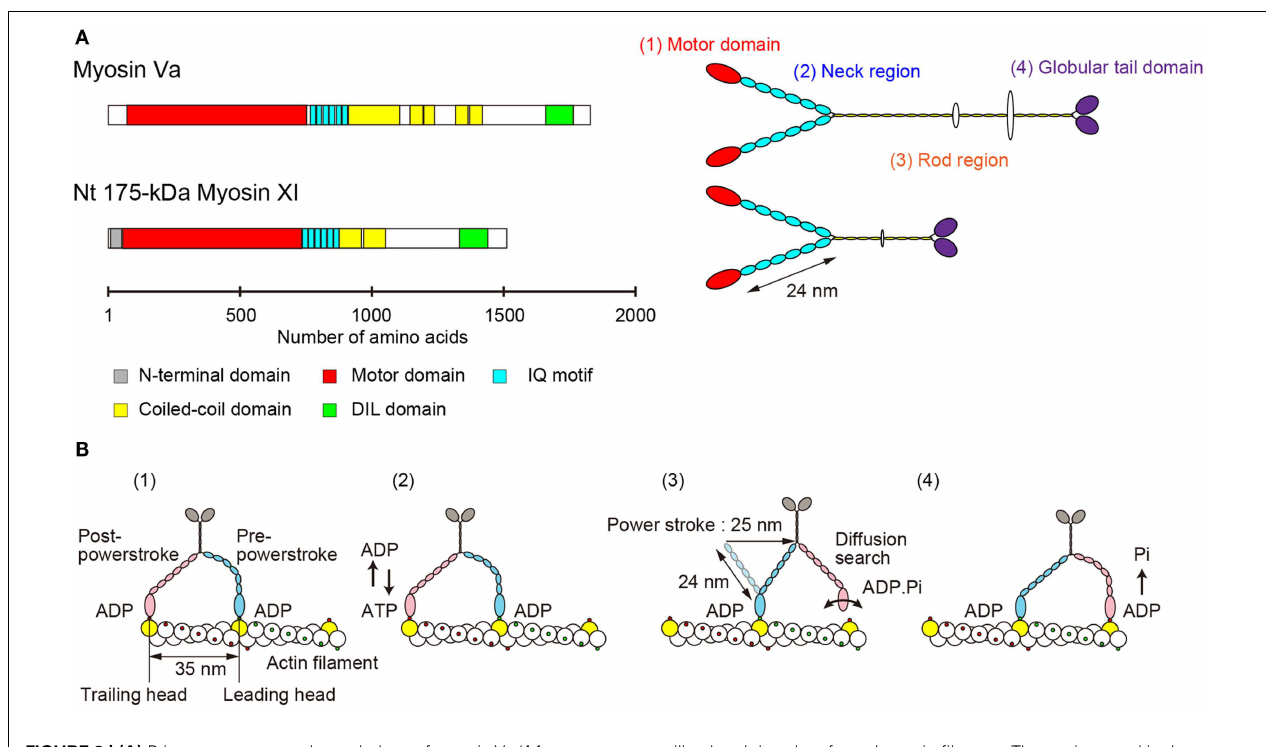
FIGURE 2 | (A) Primary structure and morphology of myosinVa ( Mus musculus ) and Nt 175-kDa myosin XI ( Nicotiana tabacum ). (B) A general model for stepwise processive movement. (1) Both heads with ADP are strongly bound to actin subunits 35nm apart (yellow).The trailing head (red) is in a post-powerstroke state, and the leading head (blue) is in a strained, pre-powerstroke state. (2) At physiological concentrations of ATP, ADP release from the trailing head is the rate-limiting step of the mechanochemical cycle. After ADP release, a new ATP molecule binds to the trailing head. (3) Immediately, the